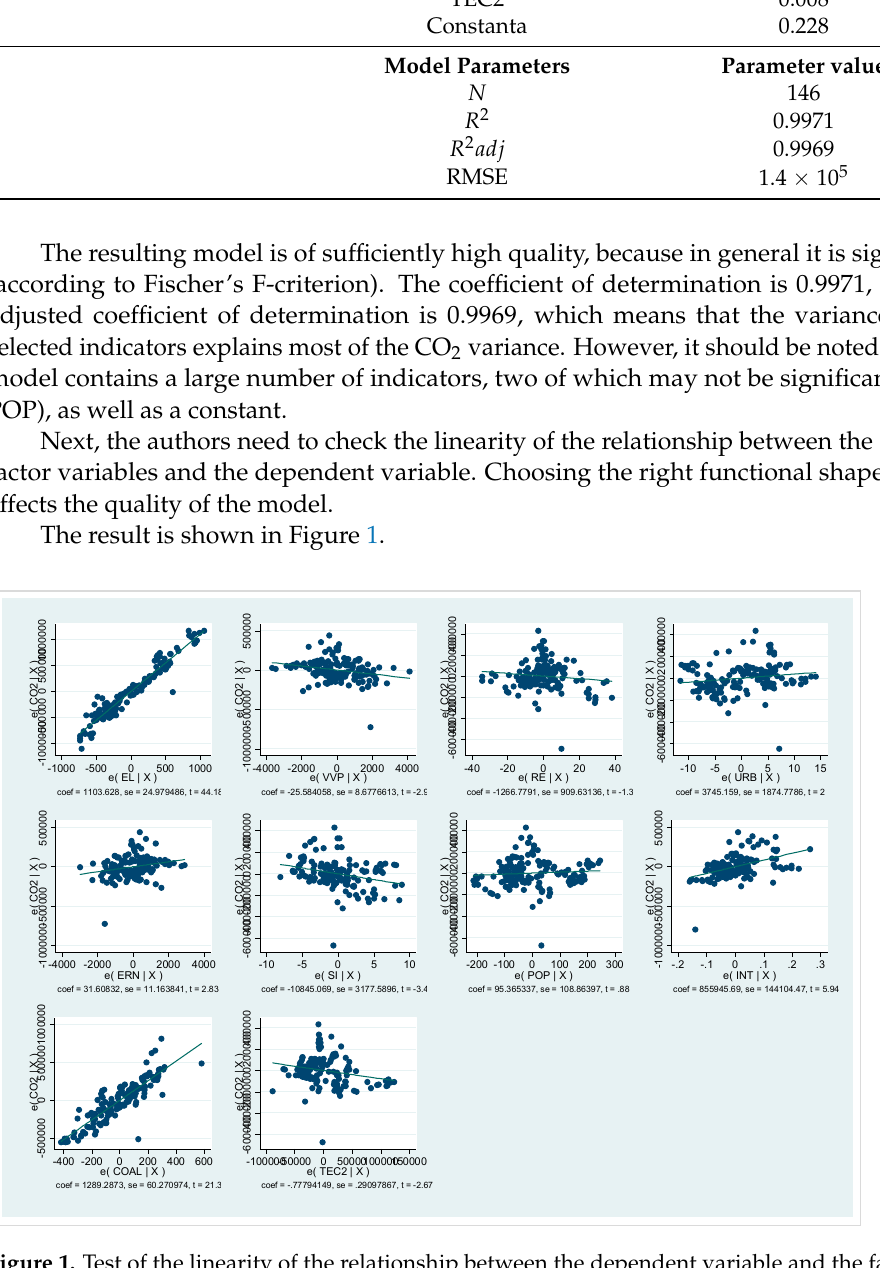
Figure 1. Test of the linearity of the relationship between the dependent variable and the factors.